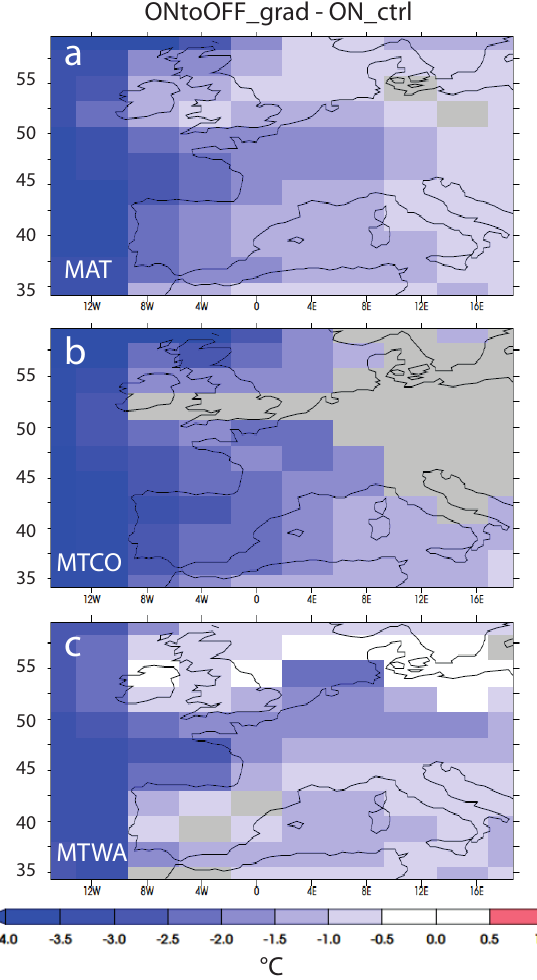
Fig. 7. Difference between ON ctrl and the end of ONtoOFF grad for (a) the mean annual temperature (MAT), (b) mean tempera- ture of the coldest month (MTCO) and (c) mean temperature of the warmest month (MTWA) ( ◦ C). Grey areas are points where the difference is not significant at the 95% level.